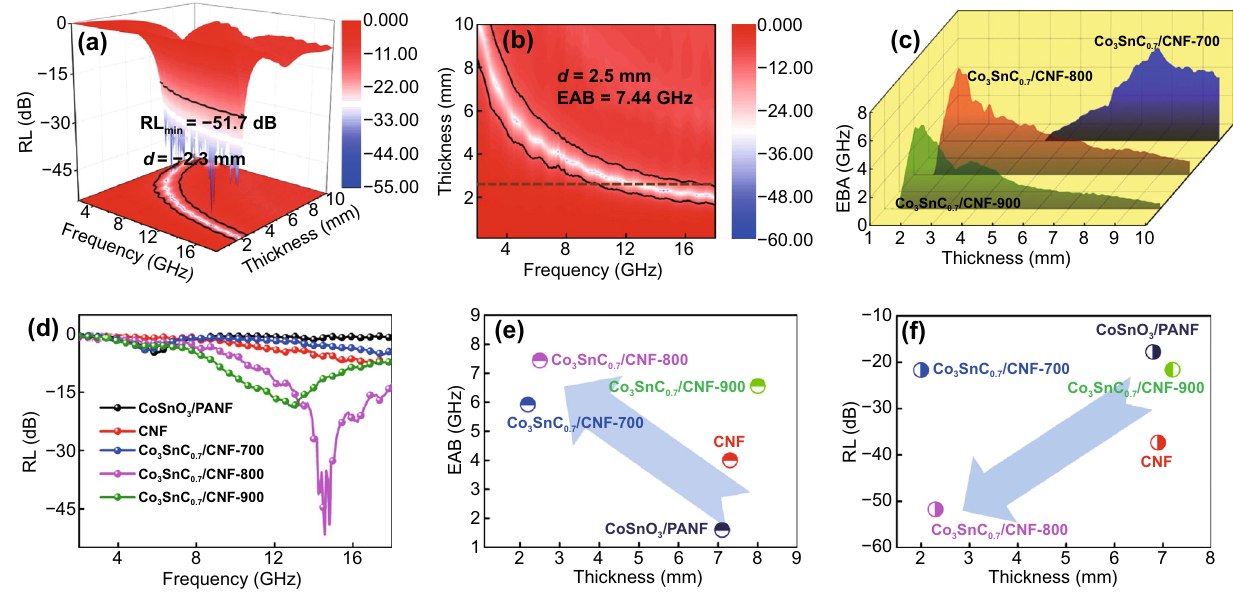
Fig. 6 3D plots of reflection loss ( a ) and the bandwidth for Co 3 SnC 0.7 /CNF-800 ( b ); the 3D effective bandwidth of Co 3 SnC 0.7 /CNF-700,